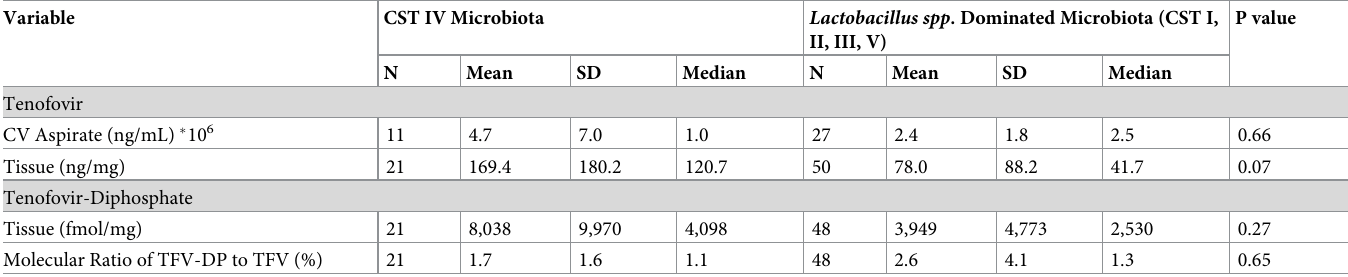
Table 3. Mucosal concentrations of TFV and TFV-DP based on community state type (CST) at end of treatment (visit 7) for TFV and TFV/LNG IVR users combined.